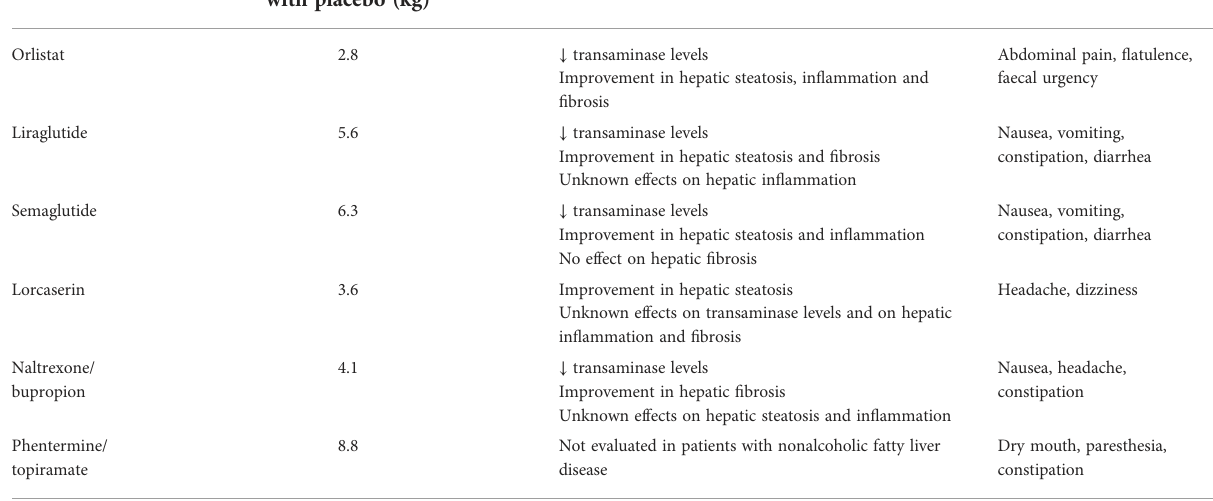
TABLE 1 Main characteristics of currently approved antiobesity